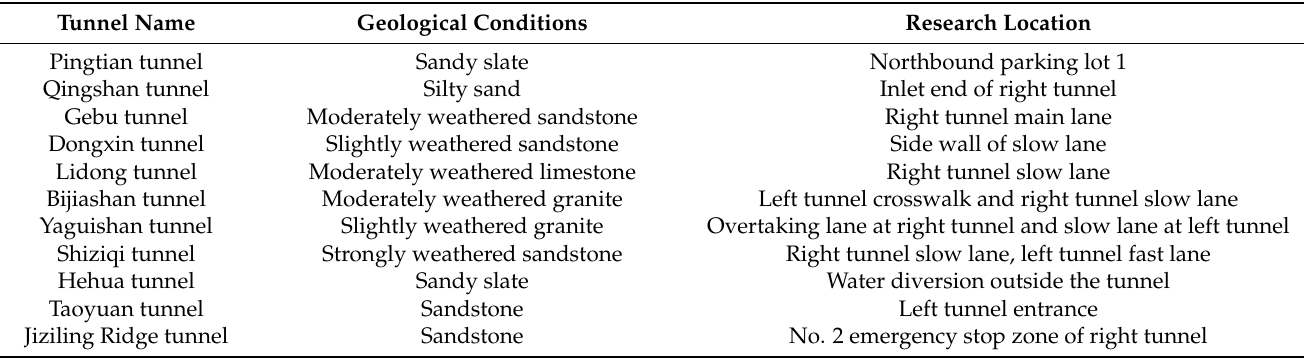
Figure 2. Tunnel site investigation (( a ): Tunnel disease; ( b ): Site sampling; ( c ): Groundwater sample; ( d ): Crystal sample). Table 1. Site investigation and distribution of